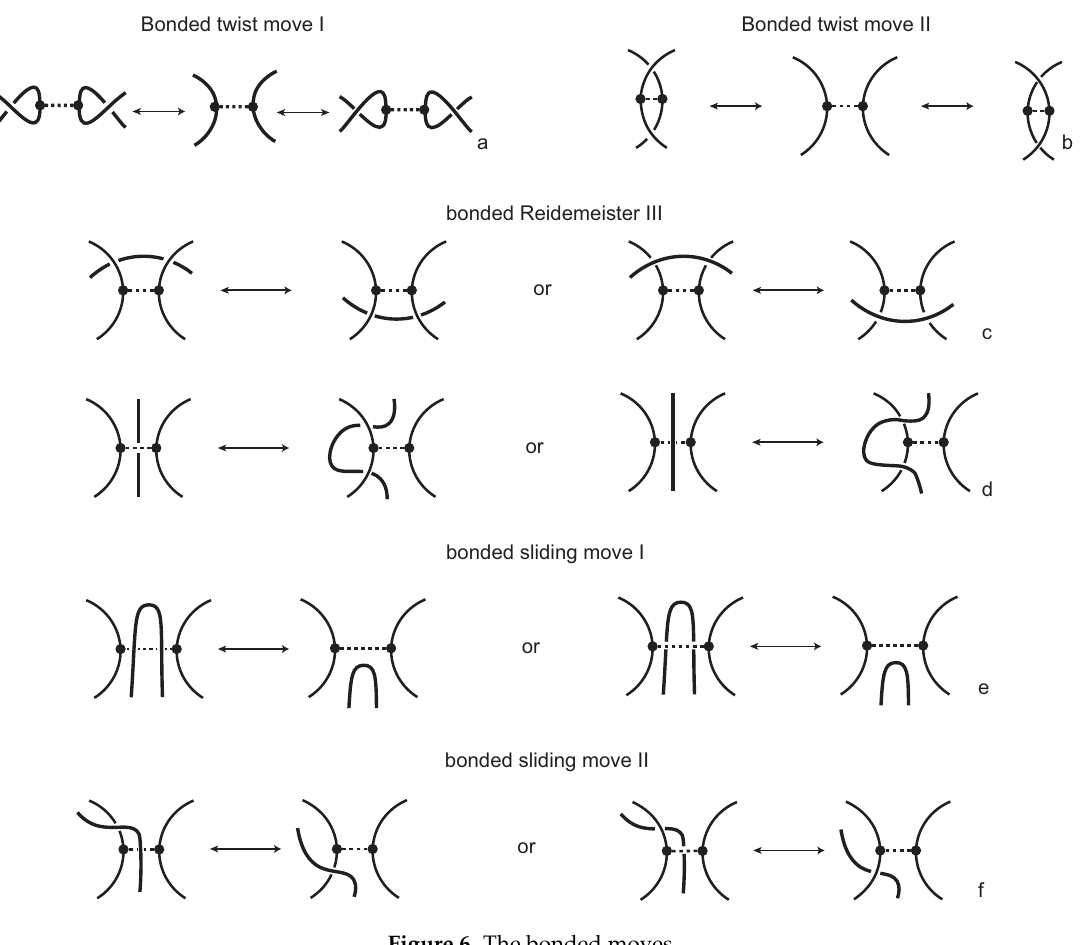
Figure 6. The bonded